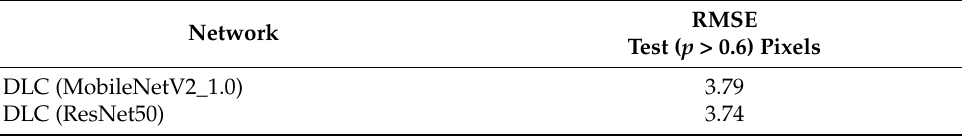
Table 7. Root mean square error (average for all lip